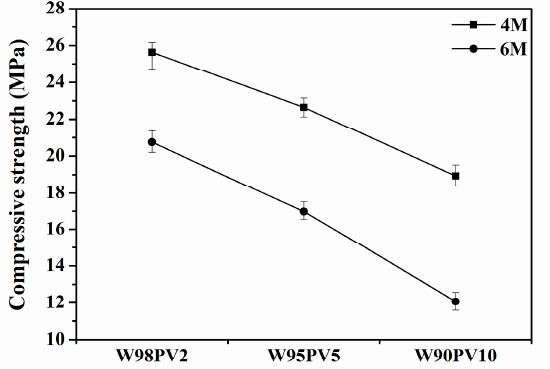
Figure 10. Compressive strength of AA-WBA/PV